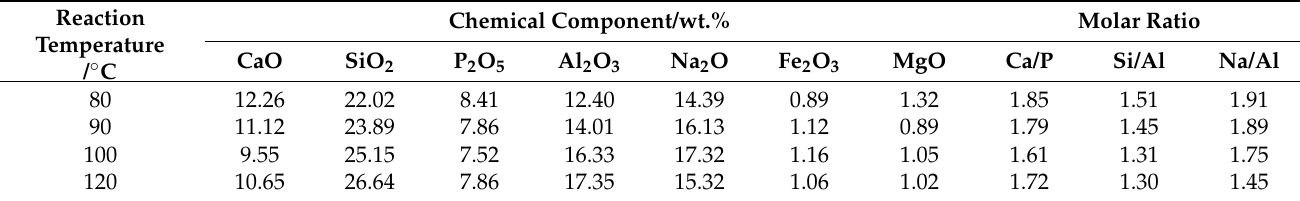
Table 3. Change of chemical components and molar ratio of Ca/P, Si/Al and Na/Al as a function of reaction temperature.